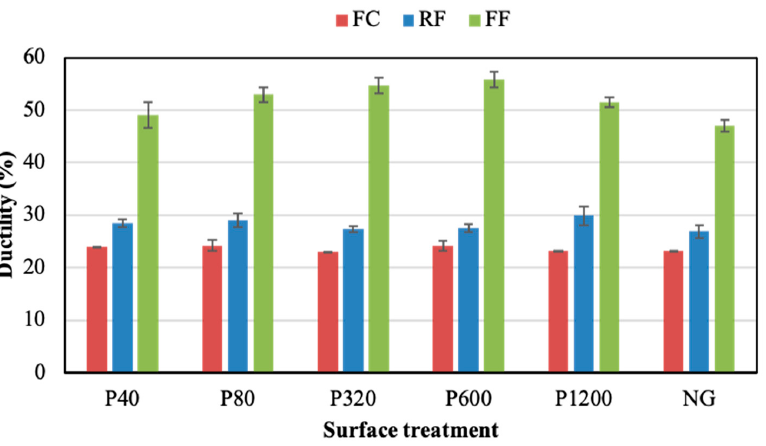
Figure 12. Ductility of the adhesive joints under different surface treatments with the adhesion pro- moter.